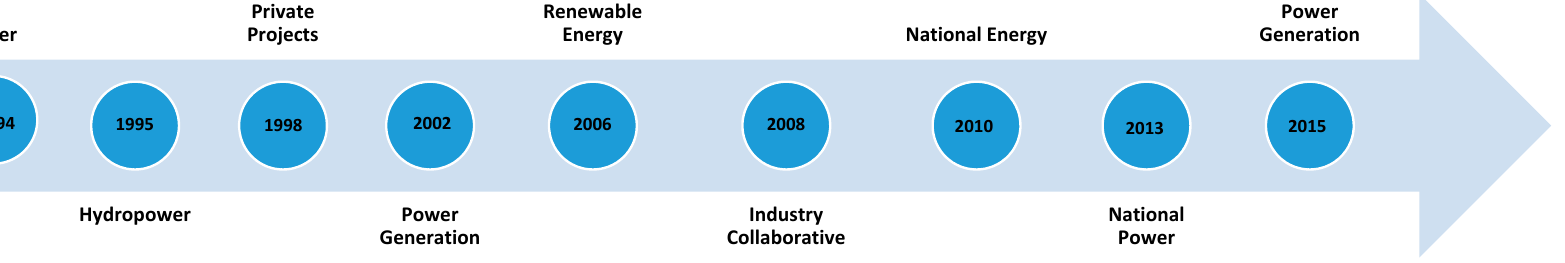
Figure 9. Timeline of Pakistan’s energy policies showing various